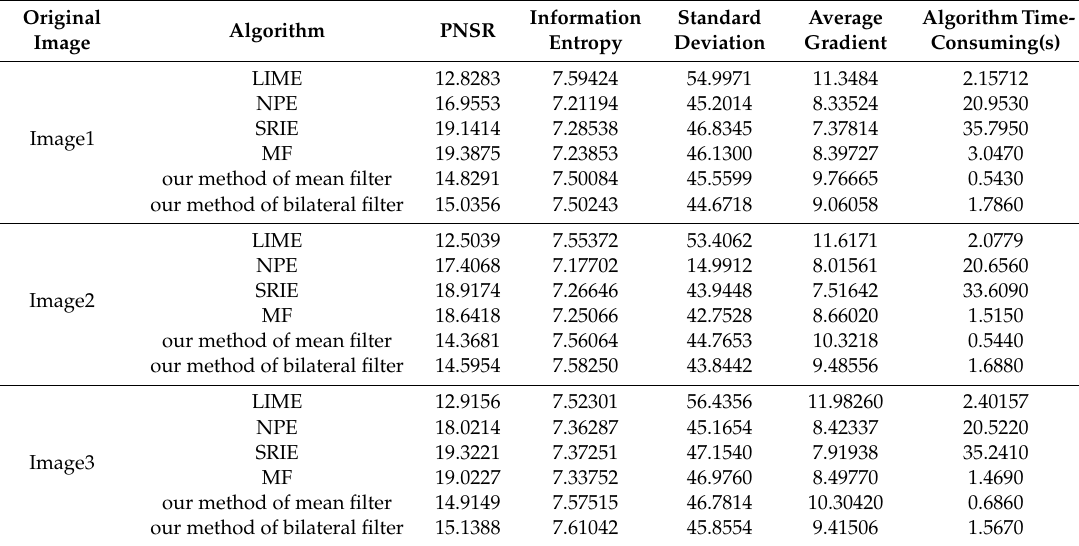
Table 2. Objective evaluation index of image enhancement